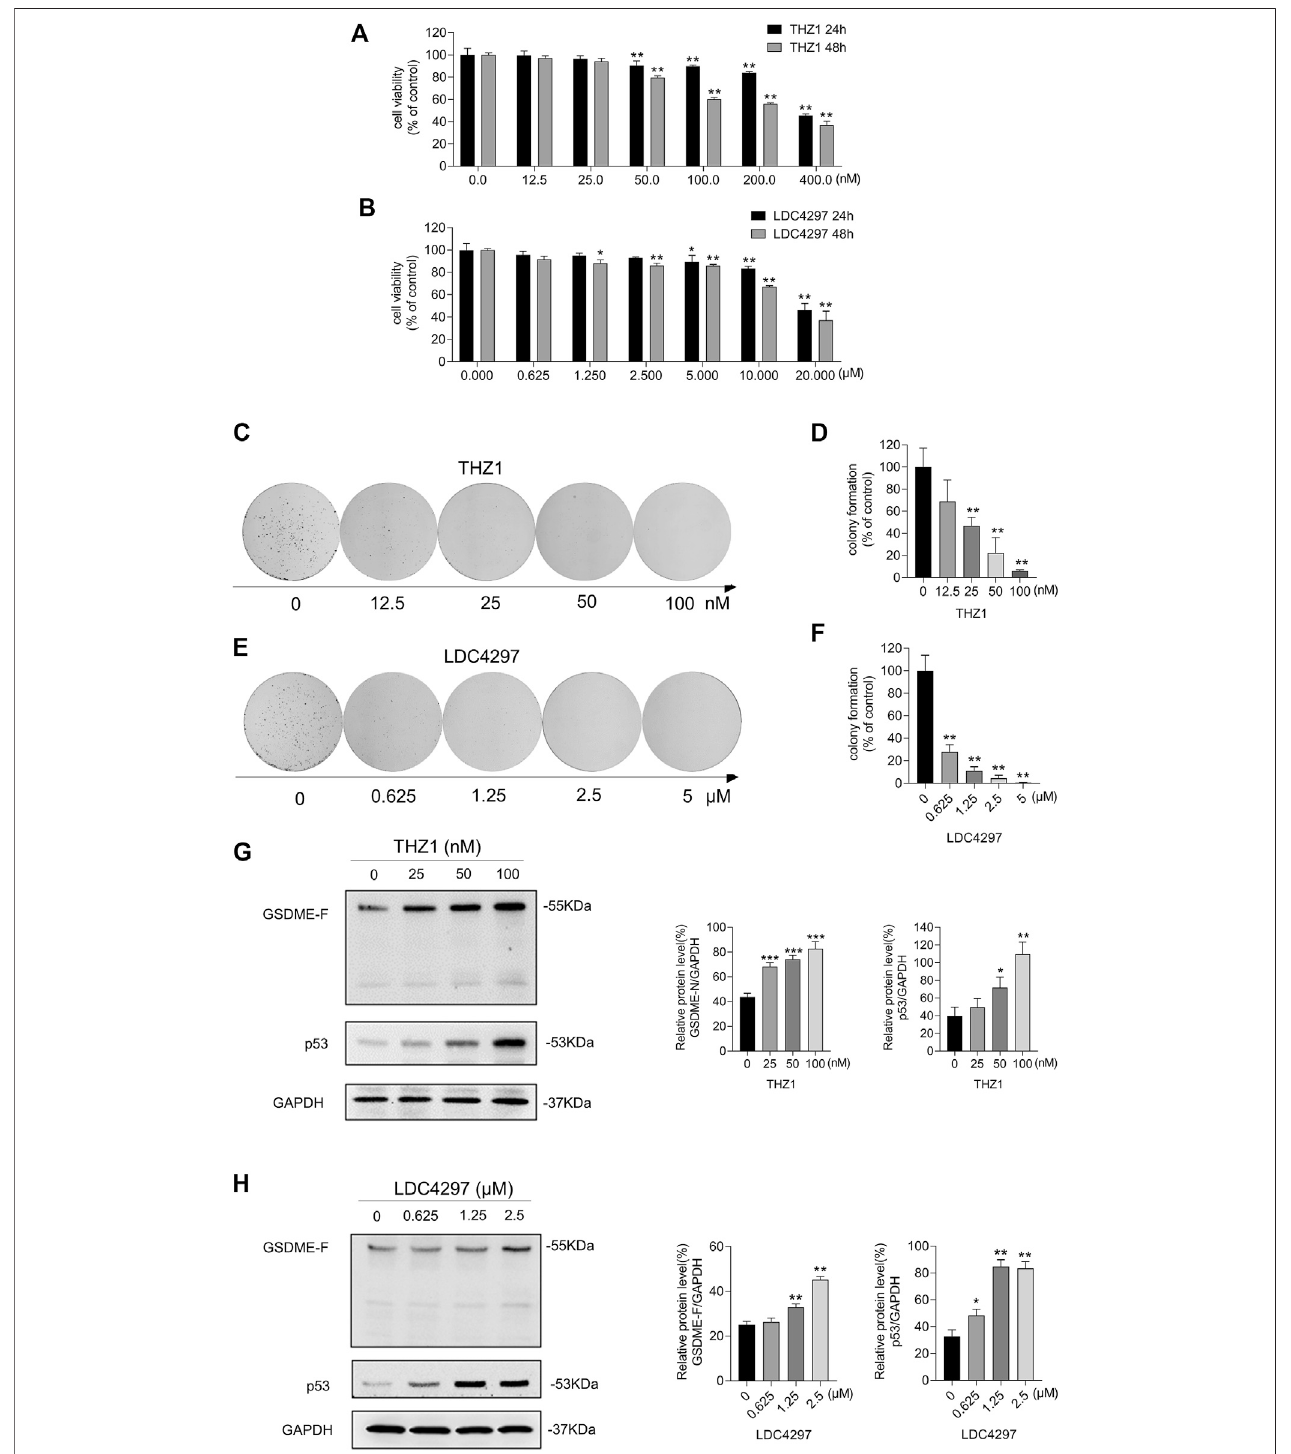
FIGURE 6 | Inhibiting CDK7 enhanced GSDME expression in ZR-75-1 cells. (A, B) The CCK8 assay was meant for detecting the viability of ZR-75-1 cells after beingtreatedwithincreasingconcentrationsofTHZ1orLDC4297for24and48 h. (C,E) ThecolonyformationabilitywasdetectedafterZR-75-1cellsweretreatedwith THZ1orLDC4297. (D,F) Quantitationofcolonyformationabilityin (C) and (E) separately. (G) WesternblotwasmeanttodetectGSDME,p53,andGAPDHproteinlevels inZR-75-1cellswhichweretreatedwithTHZ1for48 h. (H) WesternblotwasmeanttodetectGSDME,p53,andGAPDHproteinlevelsinZR-75-1cellswhichwere treated with LDC4297 for 48 h. Statistically signi fi cant: * p < 0.05; ** p < 0.01.